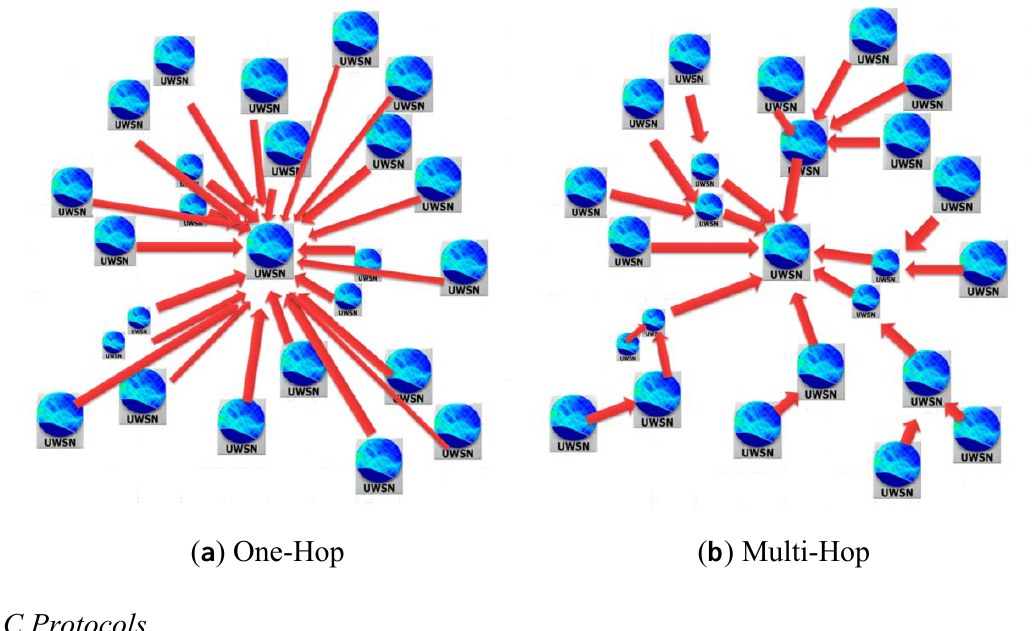
Figure 11. Network operational